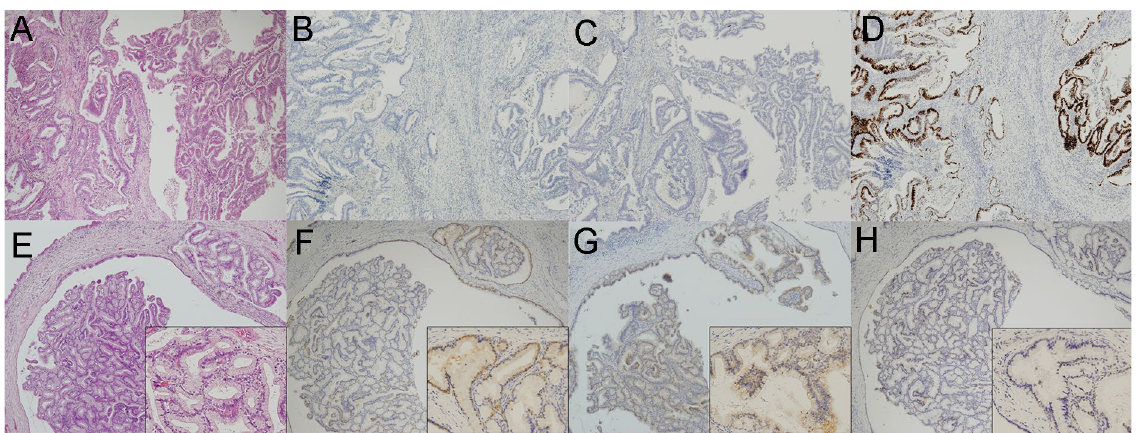
Figure 4. Representative images of a malignant-potential dissected region ( A–D ) and benign dissected region ( E–H ) showing H&E staining ( A,E ), and P16 ( B,F ), RASSF1 ( C,G ), and P53 ( D,H ) expression. Original magnification, × 40; inset magnification, ×